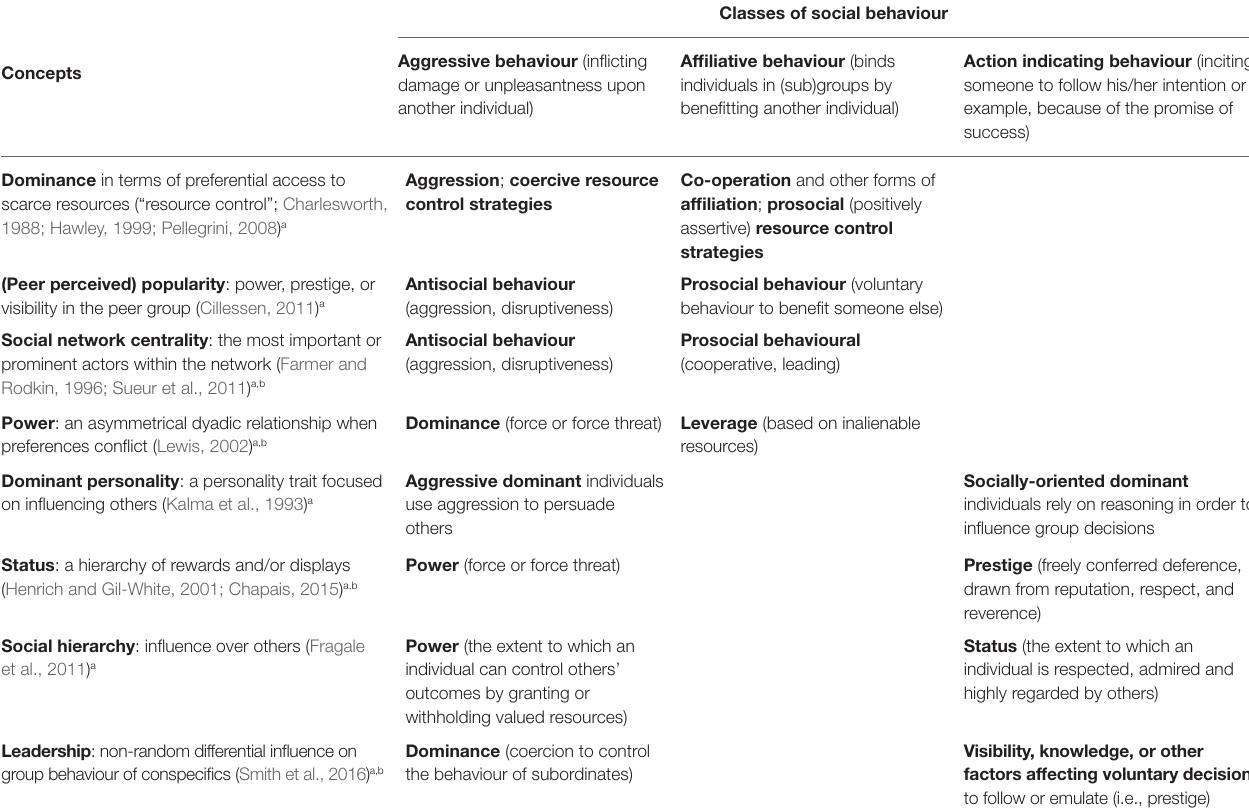
Classes of social